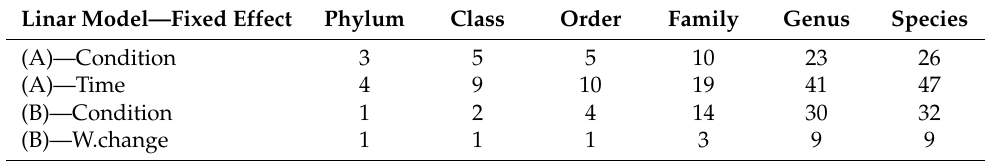
Table 1. Differential abundance analysis findings. ( A ) Linear model including all the samples; Fixed effects: Condition and Time variable. Random effects: Batch DNA extraction and Animal (to indicate a paired analysis). ( B ) Linear model taking into consideration only post samples; Fixed effects: Condition and Change of weight (W.change) variables. Random effect: Batch DNA extrac- tion.